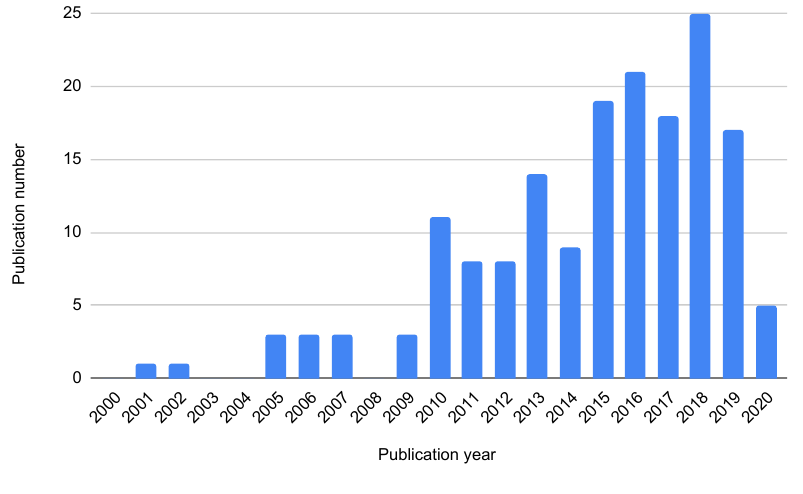
Figure 1. Publication year distribution of review results. Table 6. Country distribution of review